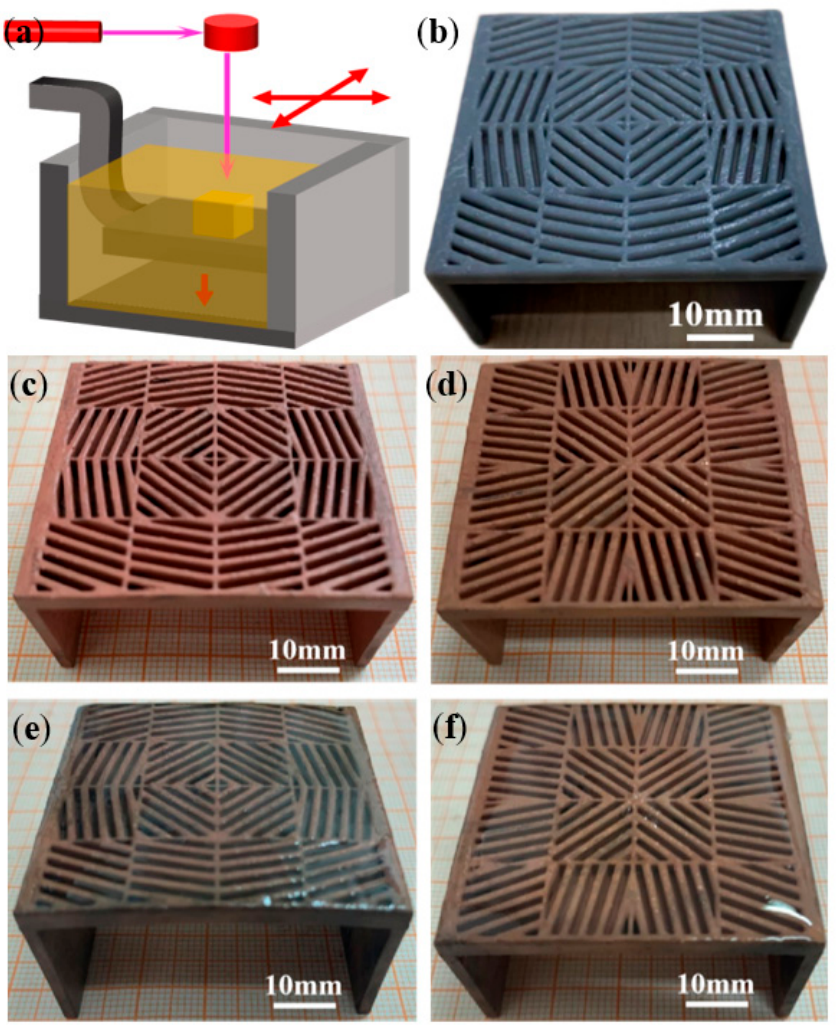
Figure 11. Fabrication results of the meta-structural devices: schematic of SLA ( a ) for 3D printing a solid resin material meta-structural device ( b ); the macroscopic appearance of thermal cloak ( c ) and thermal concentration ( d ) meta-structural devices after surface copper metallization; the macroscopic appearance of thermal cloak ( e ) and thermal concentration ( f ) meta-structural devices after nearly adiabatic packaging using PDMS.